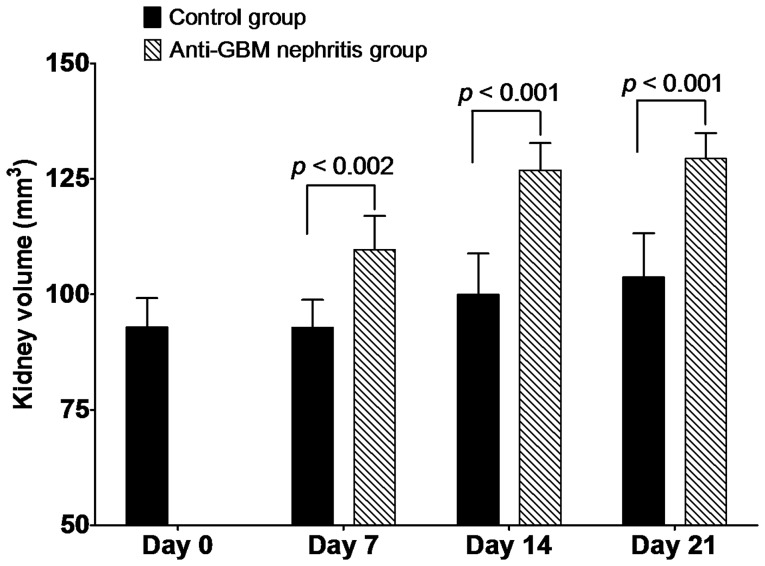
CT image derived kidney volume.Renal volume was calculated from PET-CT scans using manufacturer’s software (n = 3 per group, per time point). The rate of rise in kidney volume in the nephritis group clearly exceeded the increase that might be associated with growth in the control group.